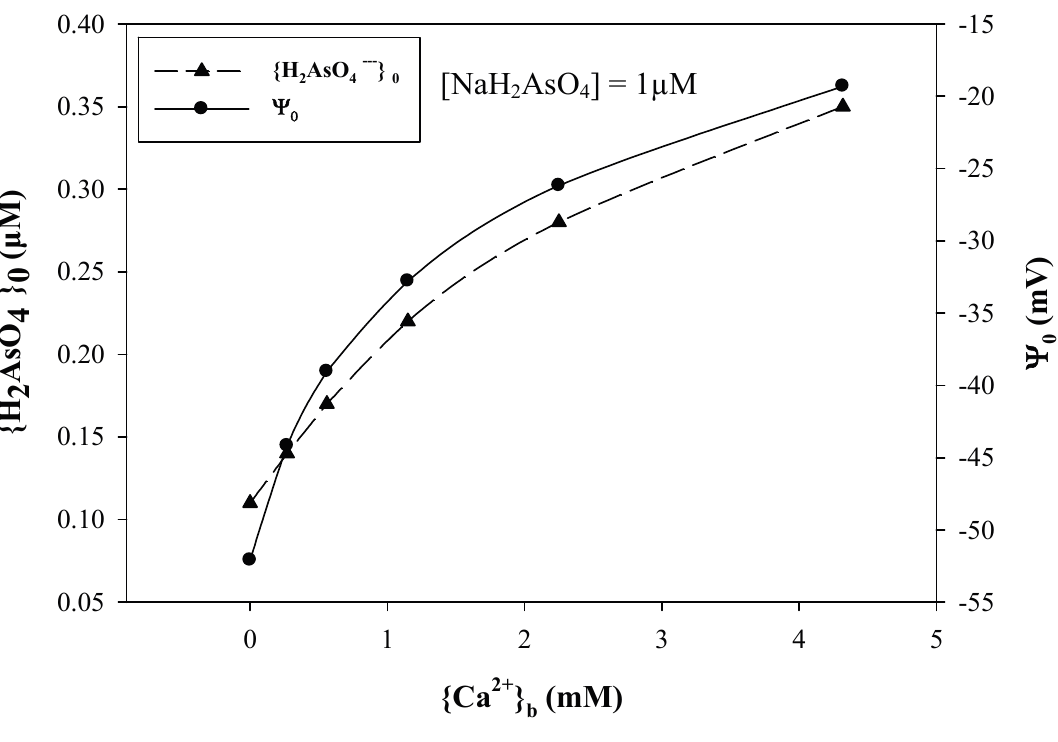
Figure 5. The calculated PM surface activities of H 2 AsO 4 − ({H 2 AsO 4 − } 0 ) at 1.0